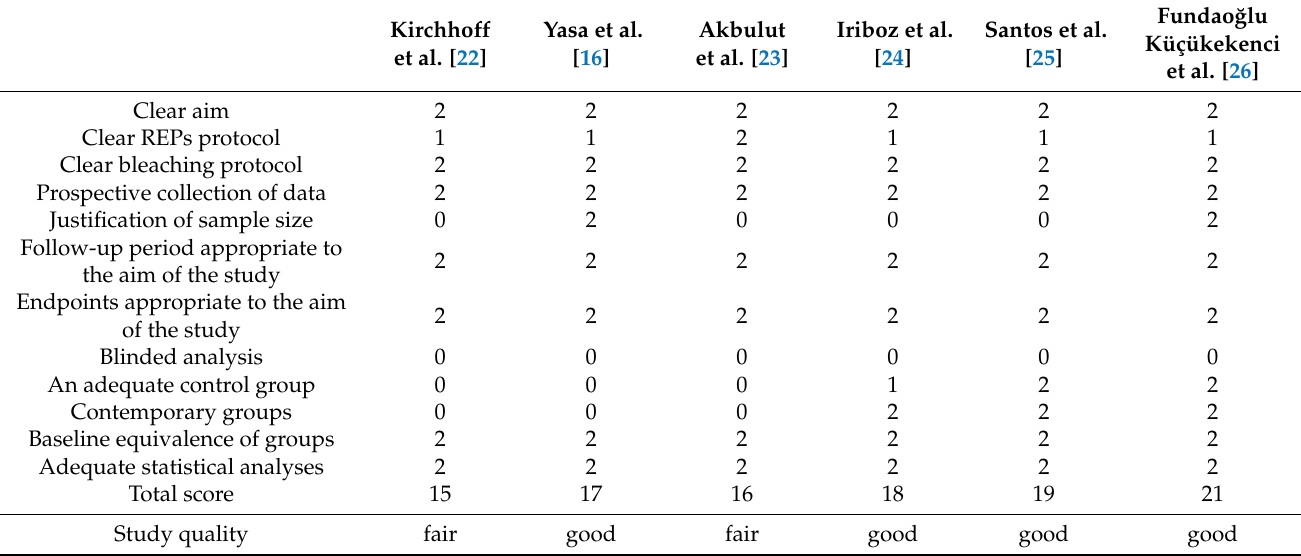
Table 2. Risk of bias according to the modified Methodological Index for Non-randomized Studies (MINORS) scale in in vitro studies.